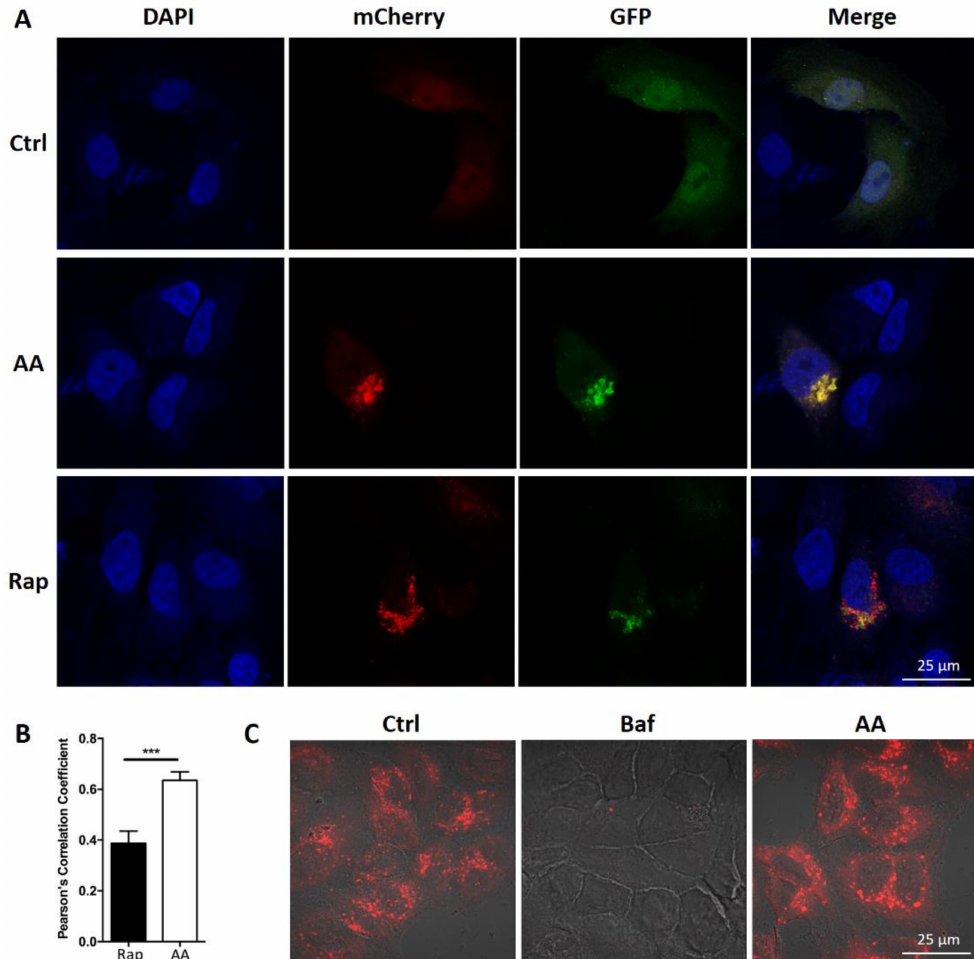
Figure 3. AA impaired autophagic influx. ( A , B ) Red LC3 puncta are greatly induced in cells after treatment with AA or rapamycin. Co-localized green fluorescence is significantly increased in AA-treated cells ( n = 20) as compared with rapamycin-treated cells ( n = 20). Student’s t test p -value: *** p < 0.01. ( C ) AA did not affect the fluorescent signals of lysotrackers. In contrast, Bafilomycin A1, the V-ATPase inhibitor completely abolishes the